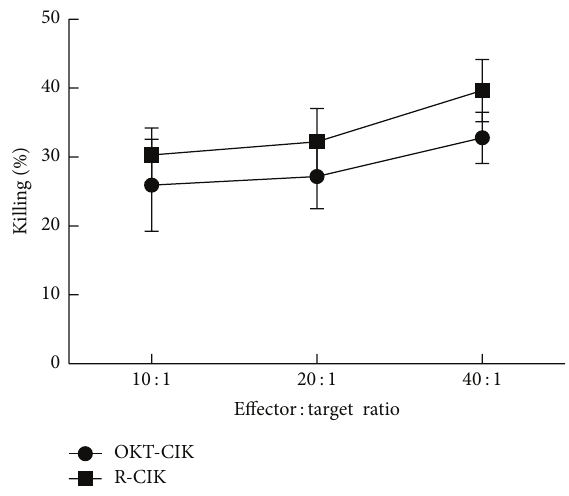
Figure 4: Cytotoxicity of OKT-CIK and R-CIK cells against K562 cells. Both OKT-CIK and R-CIK cells could kill K562 cells at different effect or target ratio, but there was no statistical difference between the two groups. 𝑃 > 0.05 , 𝑛 = 5 .